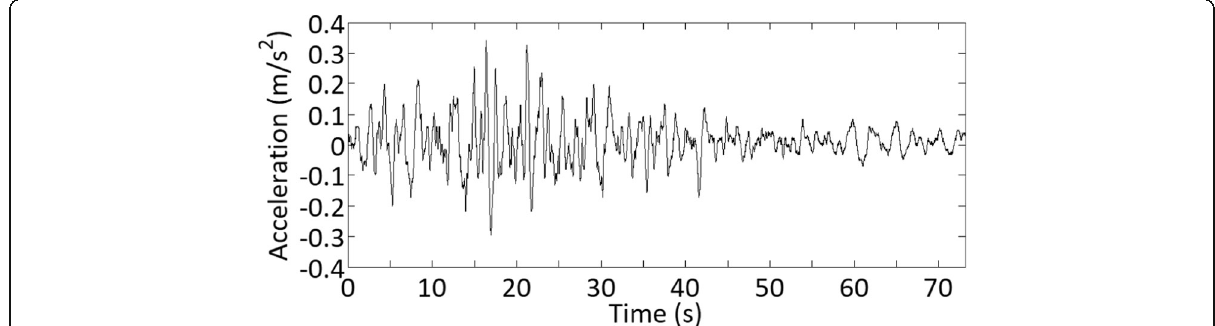
Fig. 2 Ground motions recorded at the CU station, UNAM, Mexico, for the Michoacán earthquake that occurred on September 19,